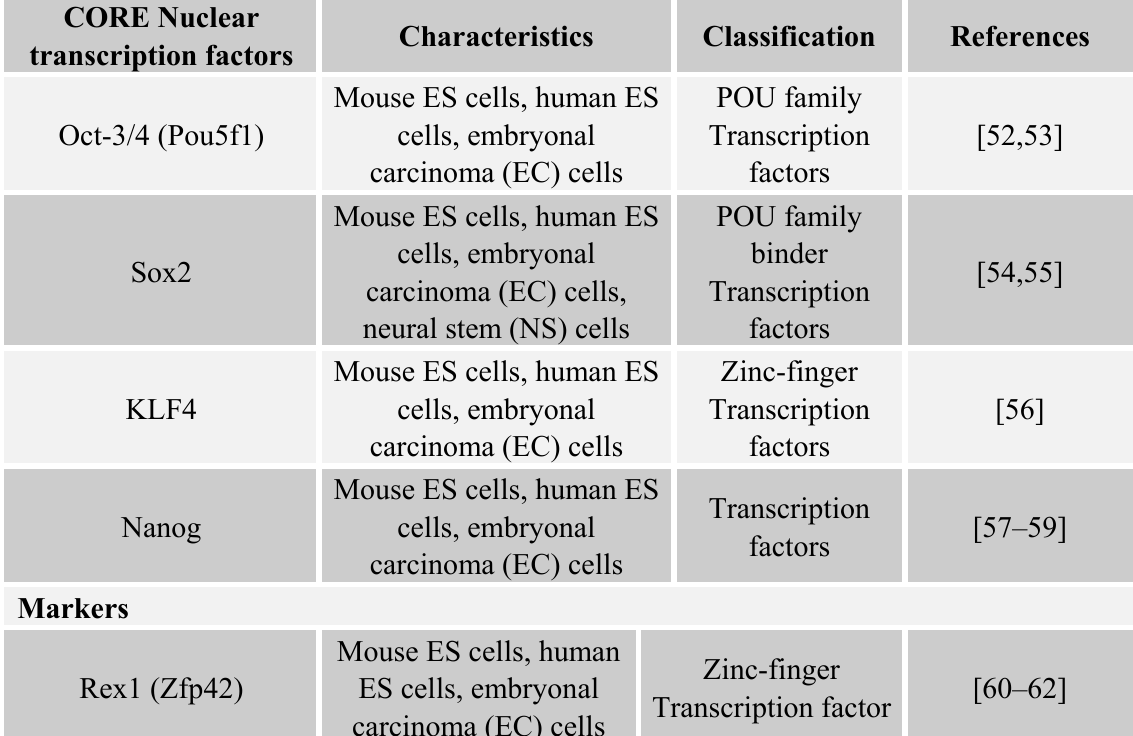
Table 2. Transcription